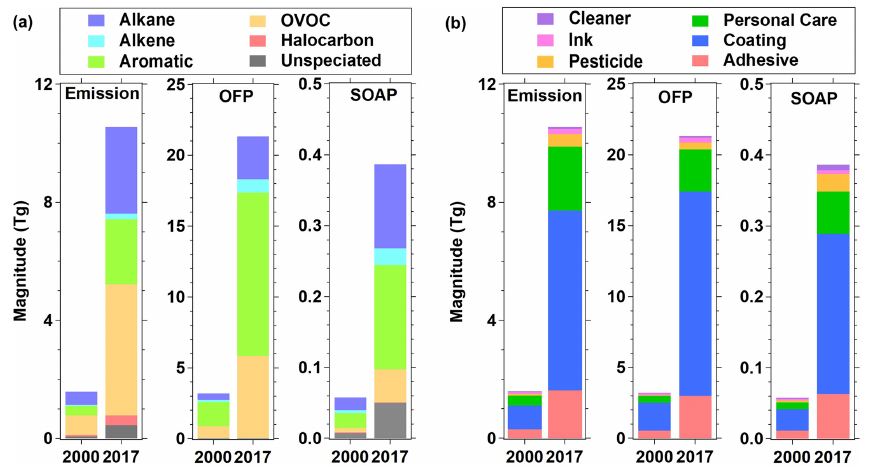
Figure 5. Contributions from (a) different source categories and (b) different NMVOC groups to emissions, OFP, and SOAP of NMVOCs from solvent use in 2000 and 2017.